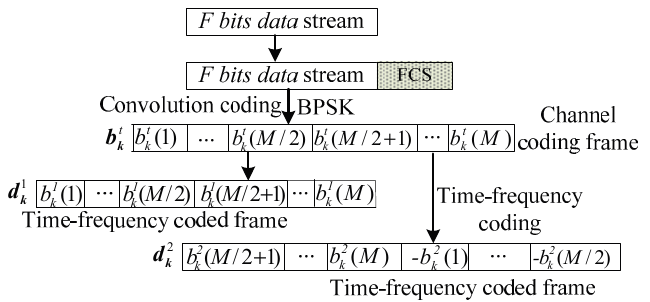
Figure 4. Time-frequency coding of the original data stream. t = 1: Phase 1; t = 2: Phase